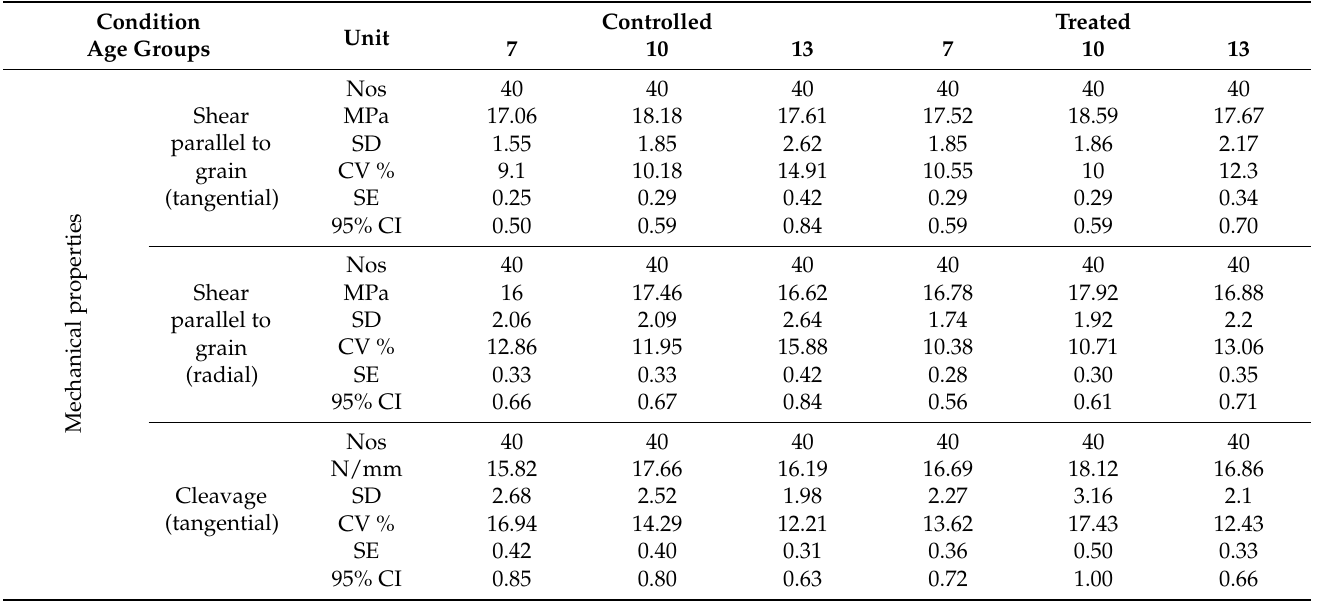
Table 1. Summary of the mean mechanical properties of Acacia